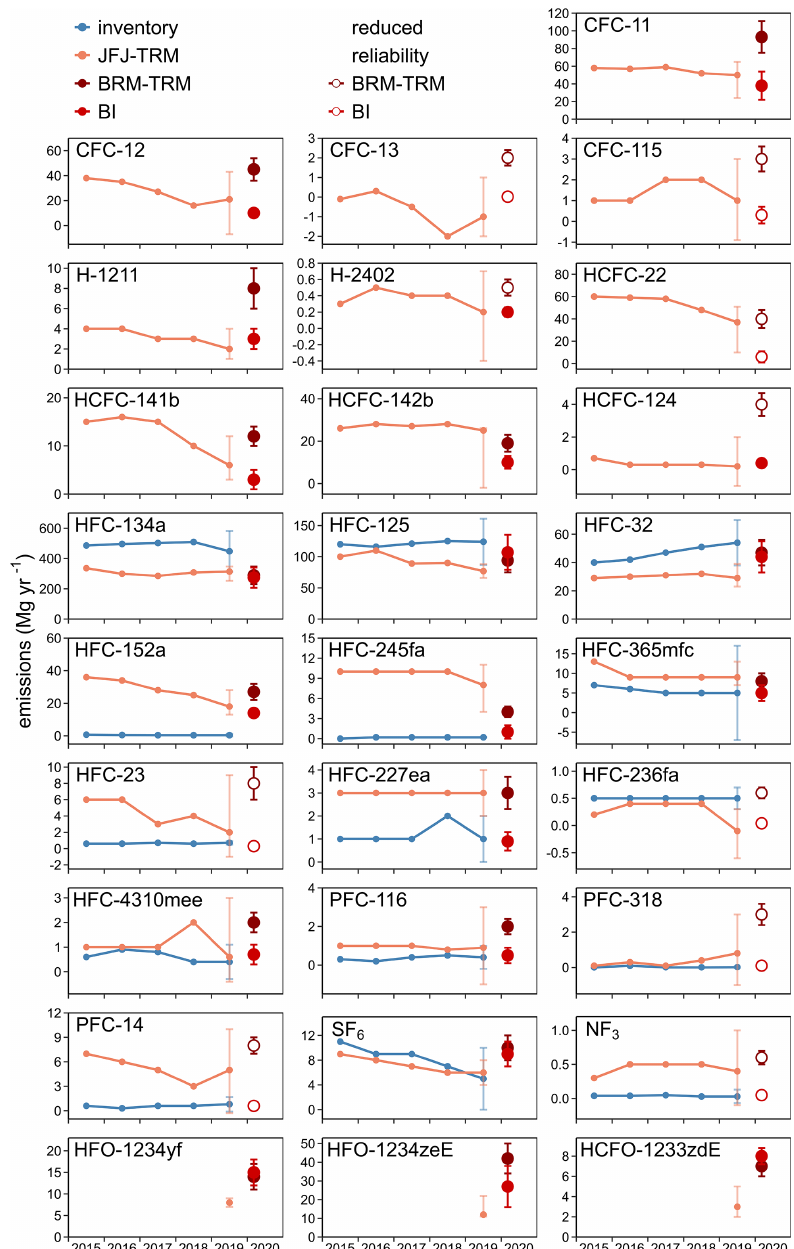
Figure 4. Calculated Swiss emissions for 2019/2020, including the Beromünster (BRM) measurements, with the tracer ratio method (TRM) and Bayesian inverse (BI) modelling. The results are compared to Jungfraujoch (JFJ)-based estimates and the Swiss bottom-up inventory. Results with reduced reliability are